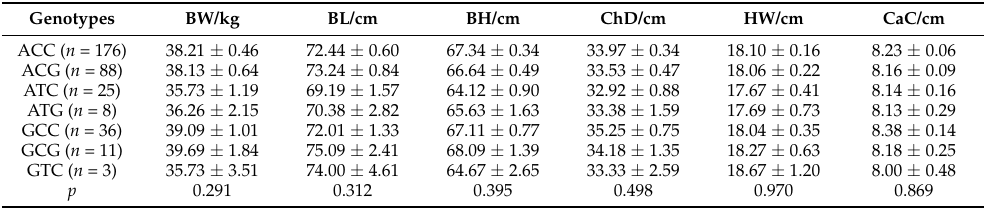
Table 8. Association analysis of haplotypes in SSTR1 with growth traits of Hulun Buir sheep at 16 months of age 1